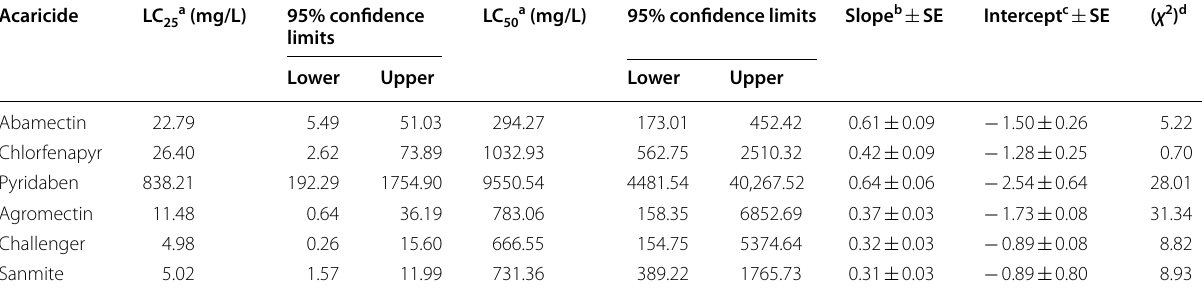
Table 1 Acaricidal activity of technical (abamectin, chlorfenapyr, and pyridaben) and formulated (Agromectin, Challenger, and Sanmite) acaricides against eggs of two-spotted spider mite T. urticae by leaf-disk-dip technique